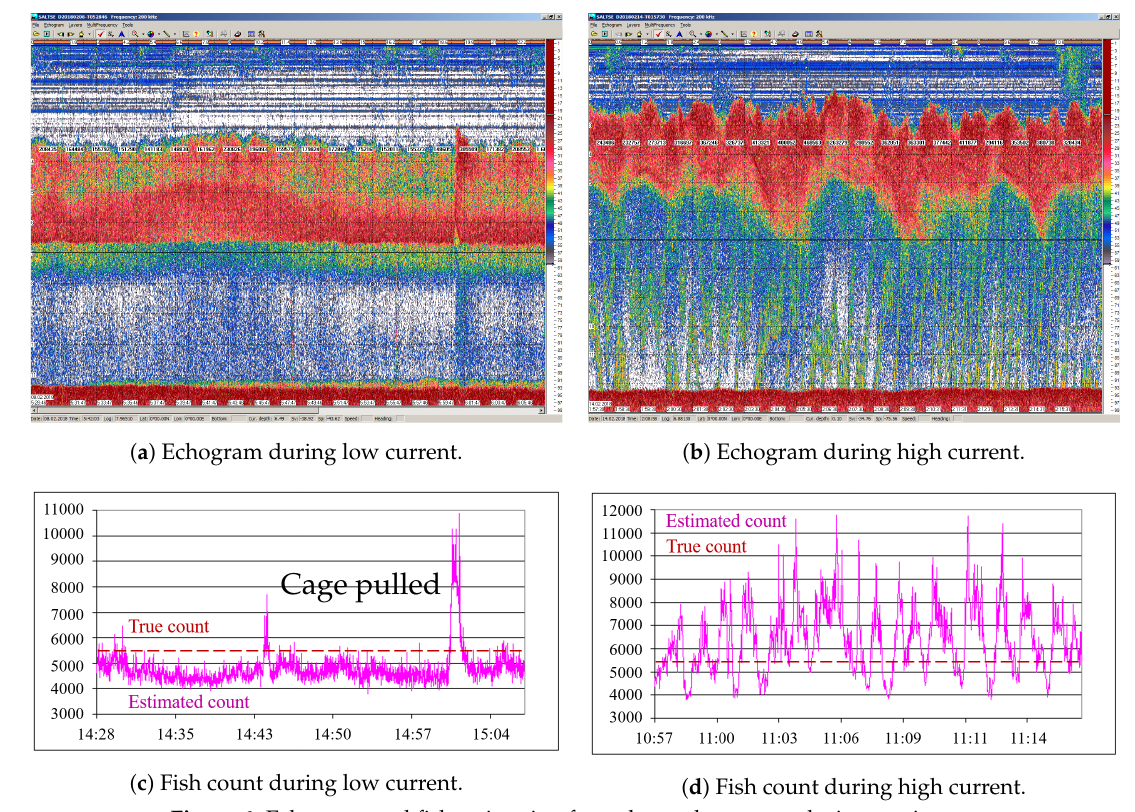
Figure 6. Echogram and fish estimation from the net bottom analysis experiment. Table 6. Estimated fish count and the error (%) of all the three cages calculated from the performed short